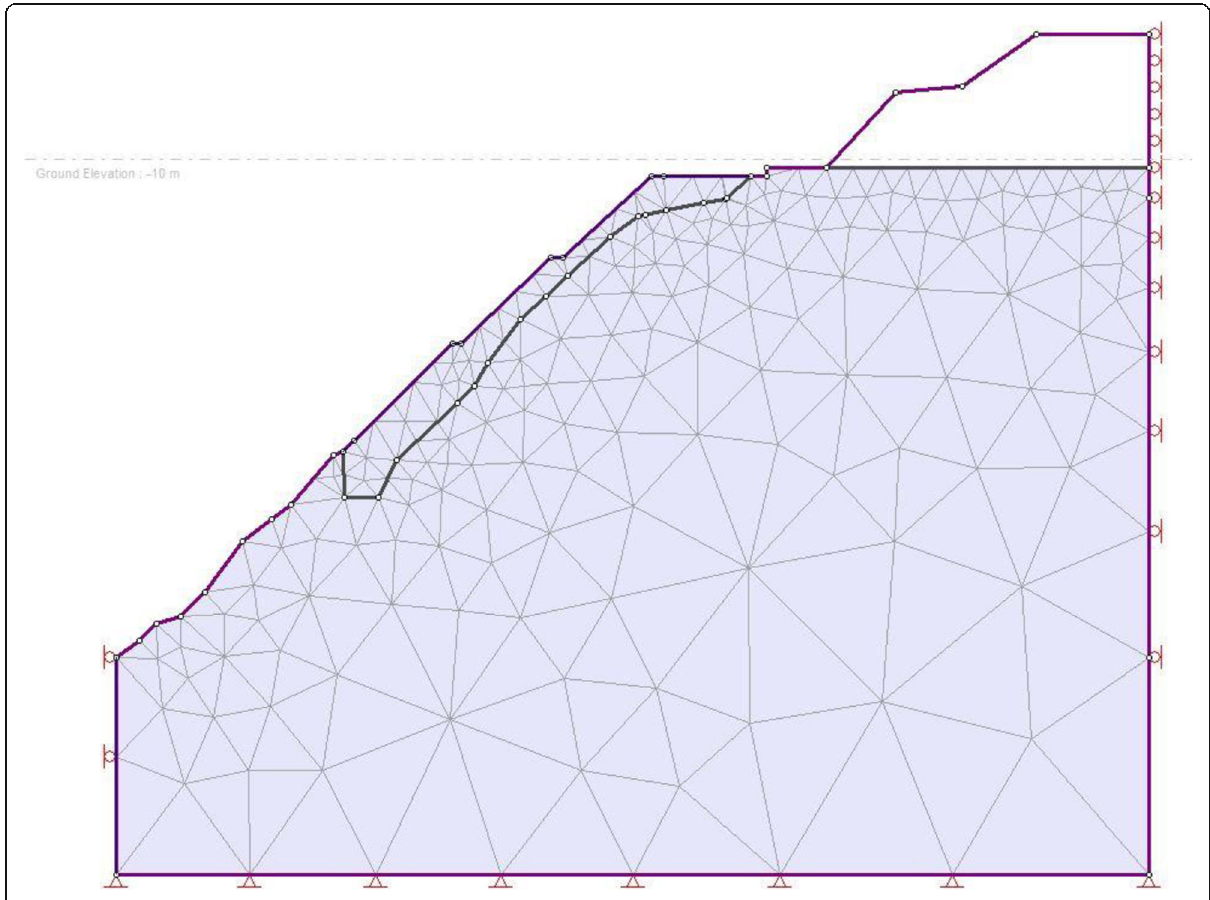
Fig. 7 Schematic diagram of slope for FEM based simulation